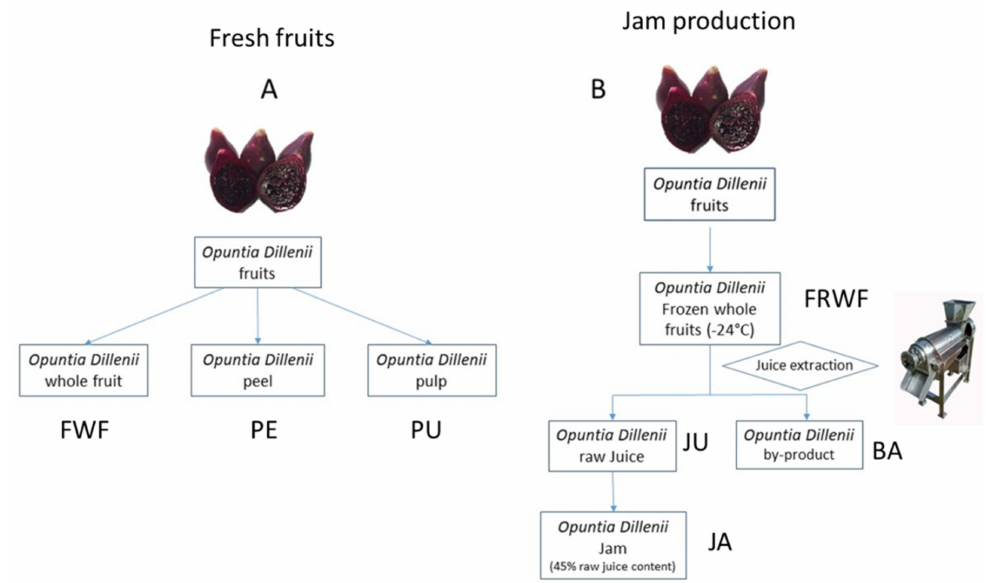
Figure 2. Scheme of Opuntia stricta var. Dillenii samples. ( A ) Fresh fruit samples (whole fruit FWF, peel PE, pulp PU), and ( B ) samples from jam production: frozen whole fruits, FRWF; raw juice, JU; by-product (bagasse), BA; jam,